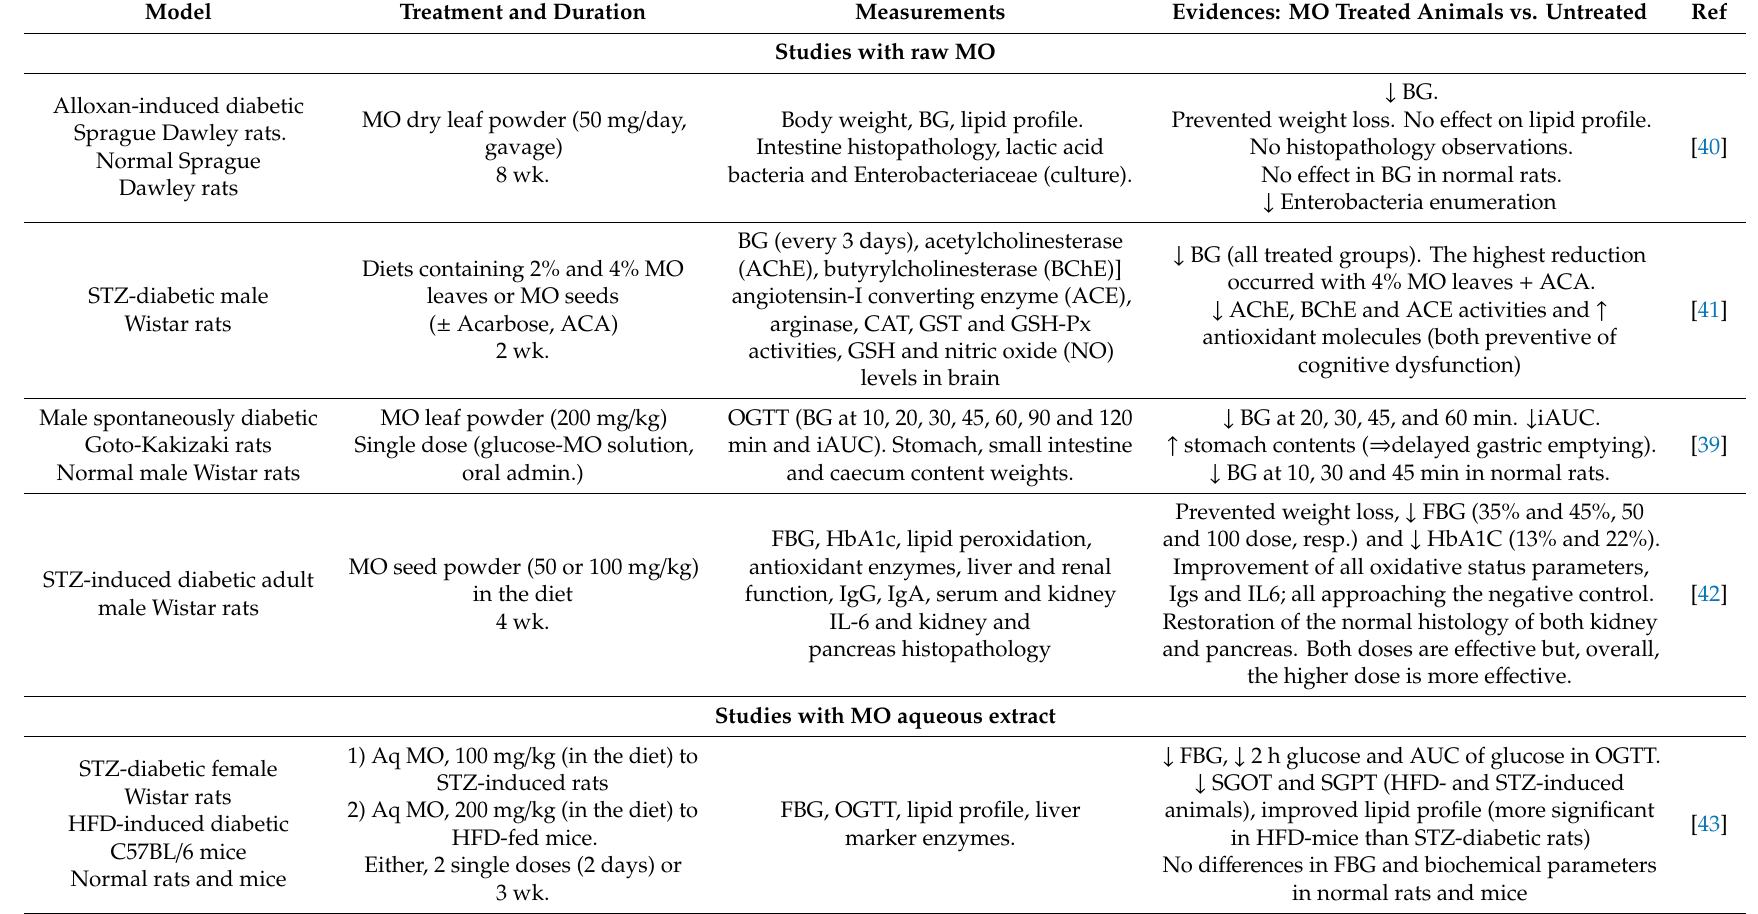
Table 1. Animal studies on the e ff ect of M. oleifera on glucose control and biomarkers related to diabetes